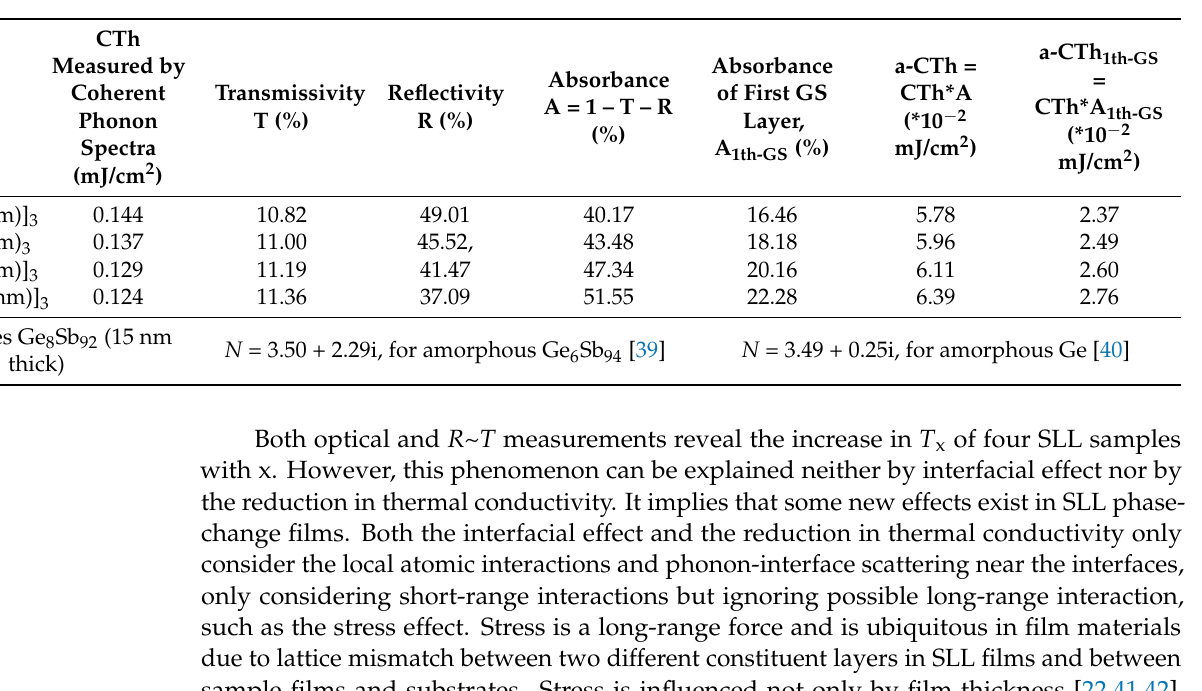
Table 1. The calculations of the total reflectivity, transmissivity and absorbance as well as the absorbance of the first Ge 8 Sb 92 layer of four SLL samples. Then, absorbed laser fluence thresholds of the whole sample and first Ge 8 Sb 92 layer are